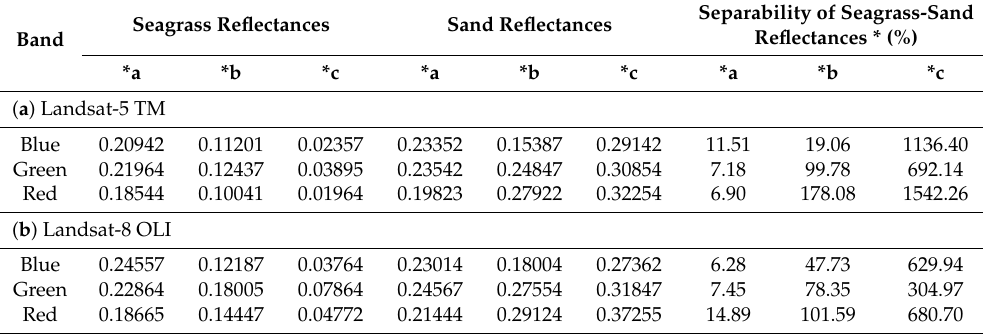
Table 5. Retrieved seagrass reflectances against its main surrounding sand refelcetances, before and after atmospheric corrections as well as the water column correction: ( a ) Landsat-5 TM; and